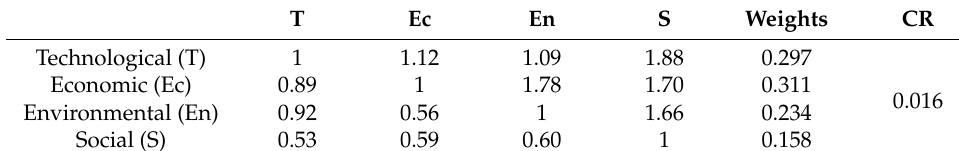
Table 2. Aggregated pairwise comparison matrices of the main criteria for all respondents.